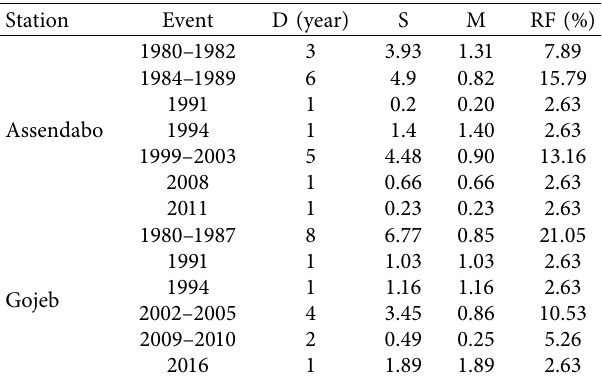
Table 7: Hydrological drought characterization in Ethiopian